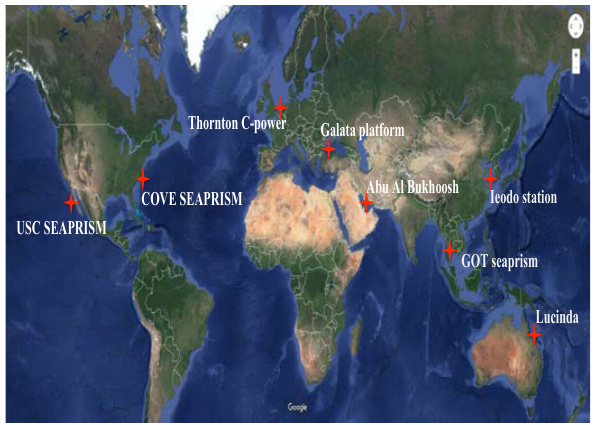
Figure 2. Locations of selected AERONET-OC stations (star sym-